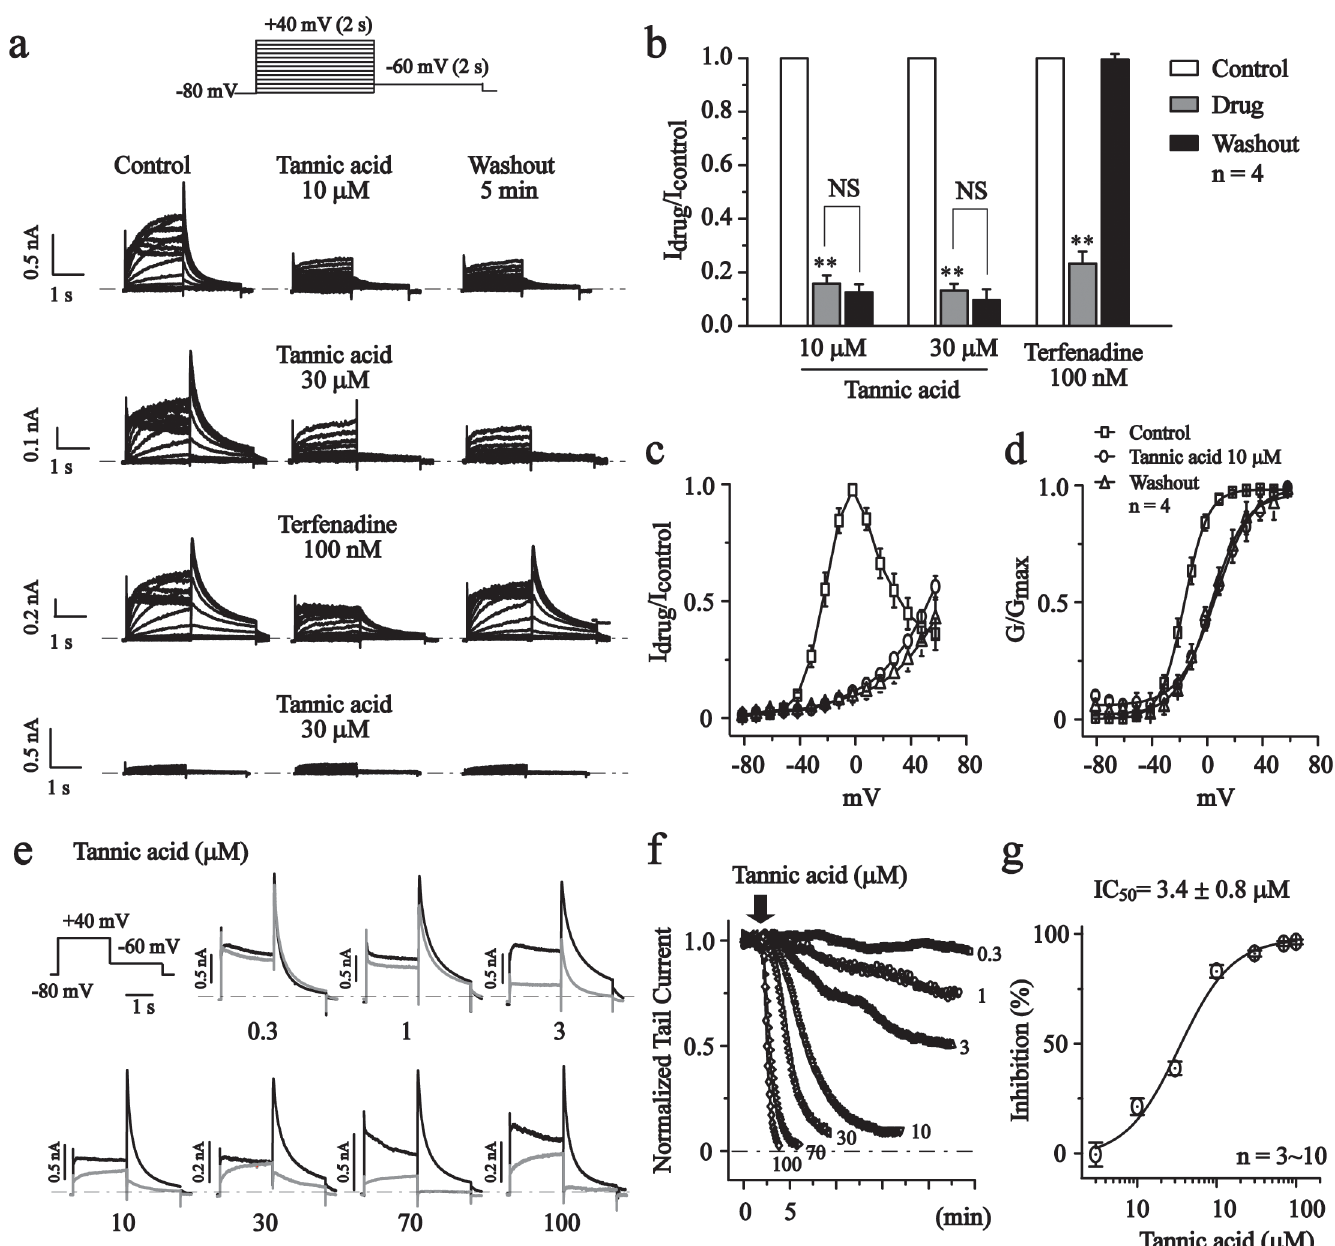
Fig 2. The effects of tannic acid on hERG currents. (a) Representative traces of hERG currents recorded using the voltage protocol indicated in the top panel. Dotted lines indicated the zero current level. The effects of tannic acid (10, 30 μ M) or terfenadine (100 nM) and 5 min washout are shown. (b) Normalized peak tail current amplitudes at -60 mV (active potential: +40 mV). ** P < 0.01, NS, no significant, n = 4. (c) Normalized I-V curves of steady-state hERG active currents. (d) Normalized G-V curves constructed from the peak tail currents at -60 mV were fitted with the Boltzmann function. The V 1/2 values were -15.4 ± 0.2 mV for the control, 7.8 ± 1.1 mV for tannic acid (10 μ M), and 4.2 ± 1.0 mV for 5 min washout, n = 4. (e) The effects of different concentration of tannic acid were shown (black trace: control, gray trace: tannic acid). (f) The time courses of concentration-dependent modulation of the hERG currents recorded at -60 mV. (g) Concentration-response relationship of tannic acid on hERG currents (-60 mV, n = 3~10). The curve was fitted with the logistic function. The IC 50 is 3.4 ± 0.8 μ